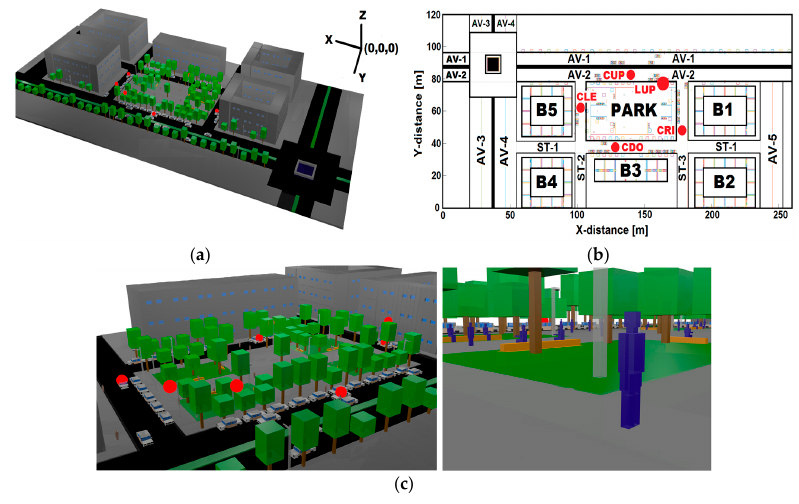
Figure 1. Scenario: ( a ) 3D frontal-view; ( b ) 2D back-view; and ( c ) close-up view. Table 1. Points of interest.